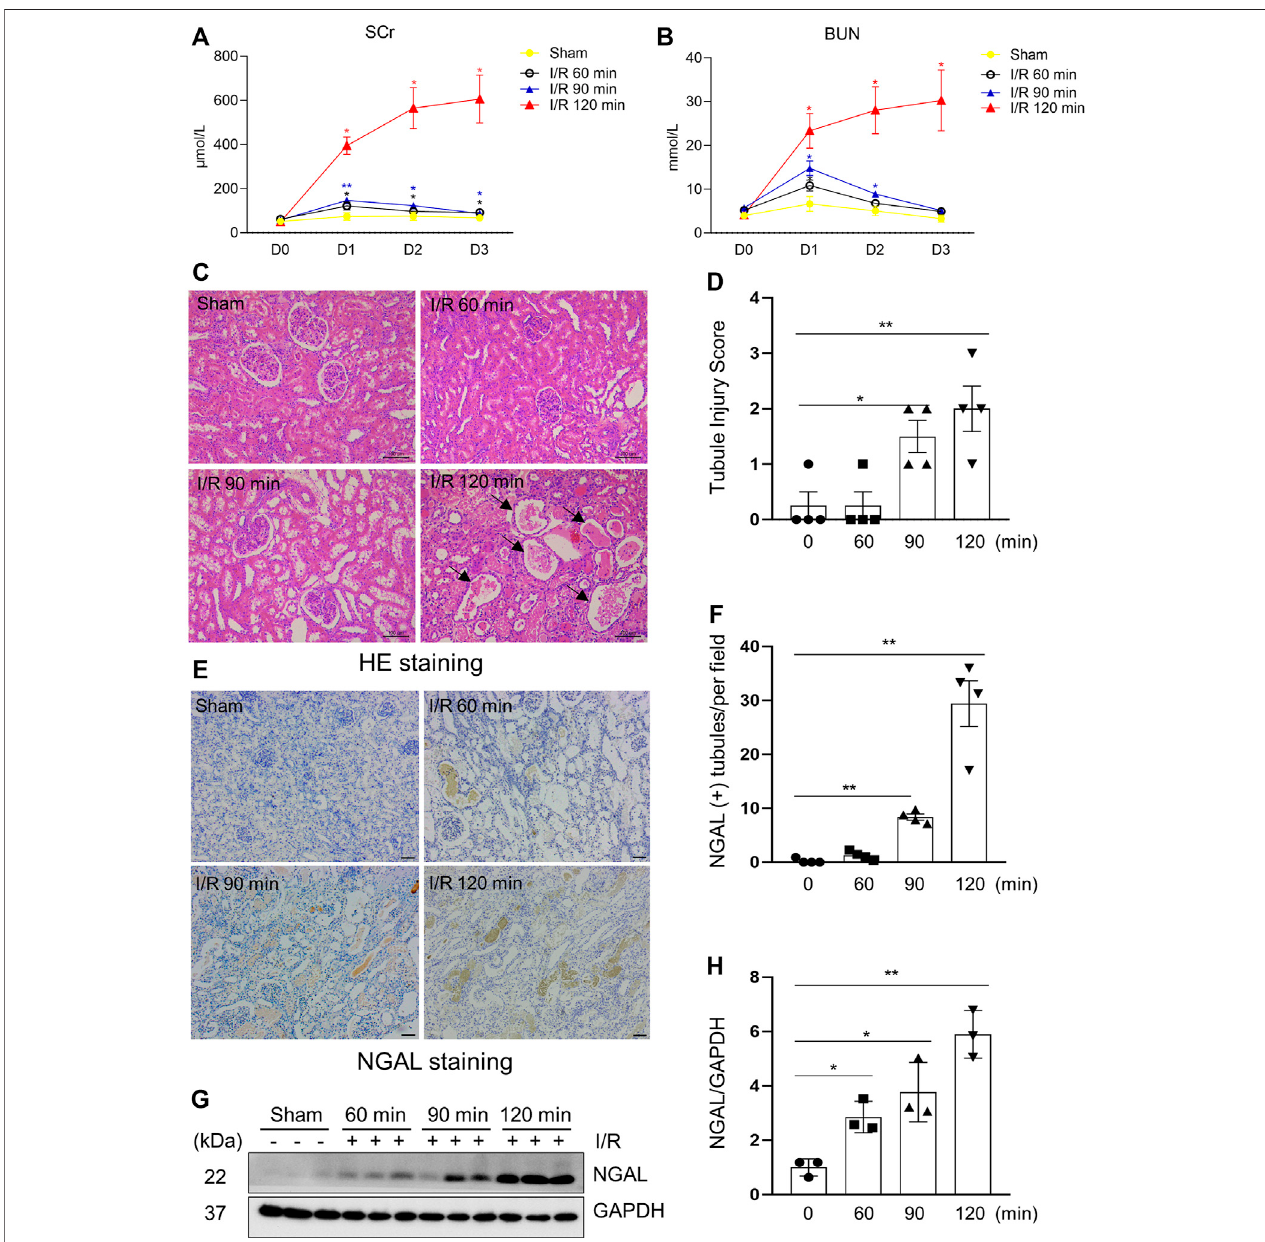
FIGURE1| Kidneyinjuryindicatorselevated after surgicalestablishment ofI/R Induced AKI inaporcineModel. (A,B) Renal function ofpigs after different ischemia durationandreperfusion(eachgroup n =4).Bloodwassampledbeforeoperationand24,48,72 hafterreperfusion.Valuesatdifferenttimepointsvs.baselinevalue(D0) from thesame groupforstatisticalanalysis. SCr,serum creatinine;BUN,blood urea nitrogen. (C) Photomicrographsillustrating hematoxylinand eosinstainingofkidney tissue from each group. Arrows point to injured tubules with intraluminal casts. (D) Tubule Injury was scored and graphed to analyze the severity of renal tubular injury. (E) Photomicrographs illustrating immunohistochemical staining of NGAL. Scale bar = 100 µm. (F) Quanti fi cation of the numbers of NGAL positive tubules from immunohistochemical staining. (G) The kidney tissue lysates from four groups were subject to immunoblot analysis with speci fi c antibodies against NGAL. (H) ExpressionlevelsofNGALwerequanti fi edbydensitometryanalysisandthennormalizedwithGAPDH(3independenttrials).Dataaremeans±sem.* p < 0.05;** p < 0.01 versus sham controls.